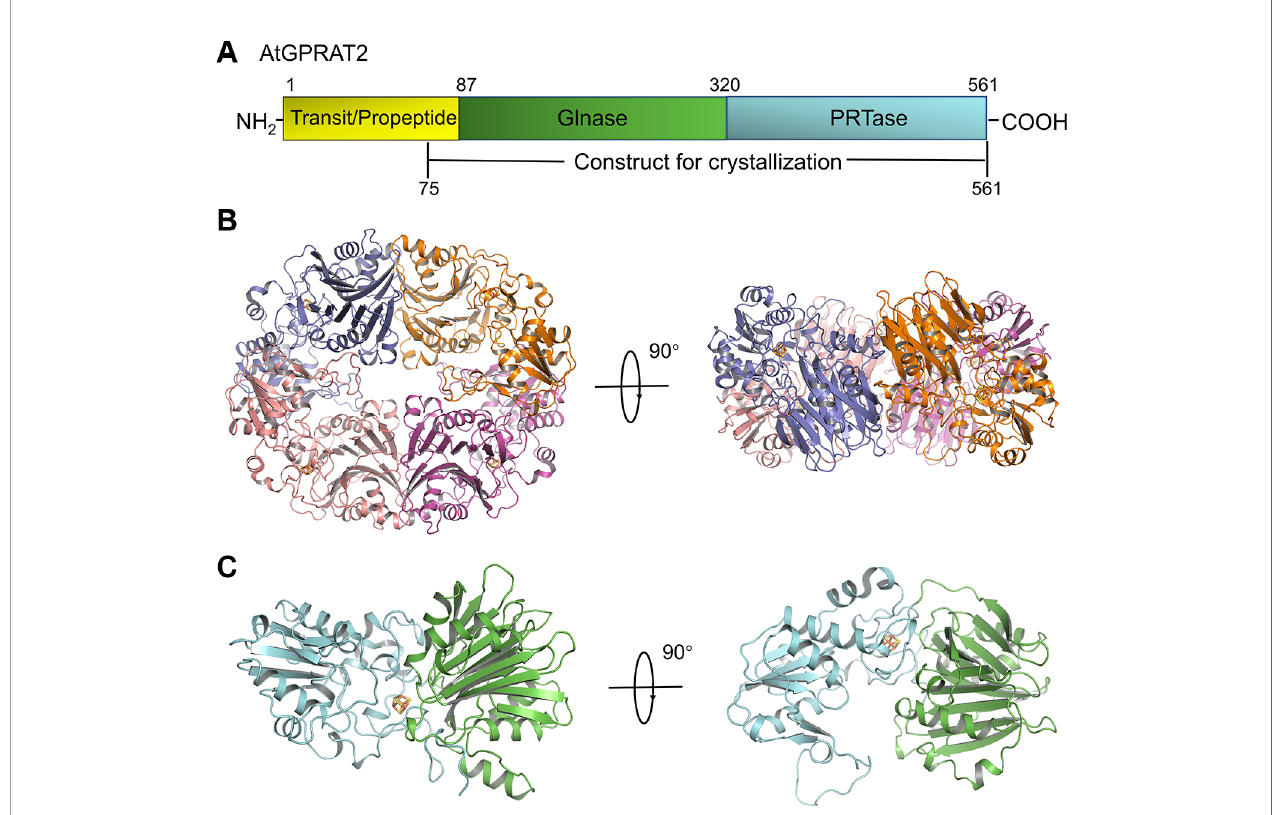
FIGURE 1 | Overview of AtGPRAT2. (A) The domain architecture of AtGPRAT2, and the construct for crystallization is indicated in the bottom. (B) Cartoon model of the tetramer conformation of AtGPRAT2. The protomers are shown in different colors and the 4Fe-4S cofactor is shown in sticks. Two views are shown. (C) Cartoon model of one protomer of AtGPRAT2. The Glnase domain and PRTase domain are colored in green and cyan, respectively. Two views are